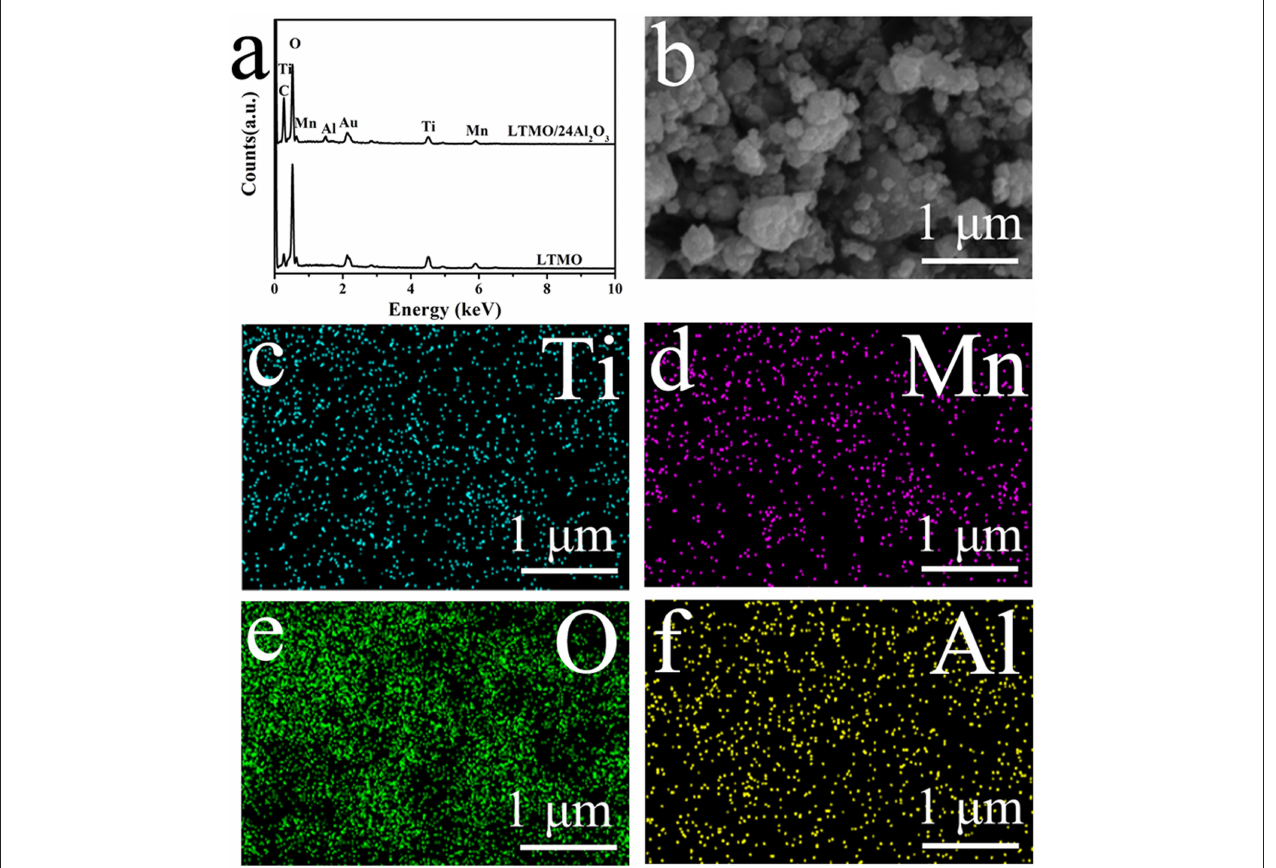
FIGURE 2 | (a) EDS element analysis LTMO and LTMO/24Al 2 O 3 ; (b–f) element mapping of LTMO/24Al 2 O 3 .